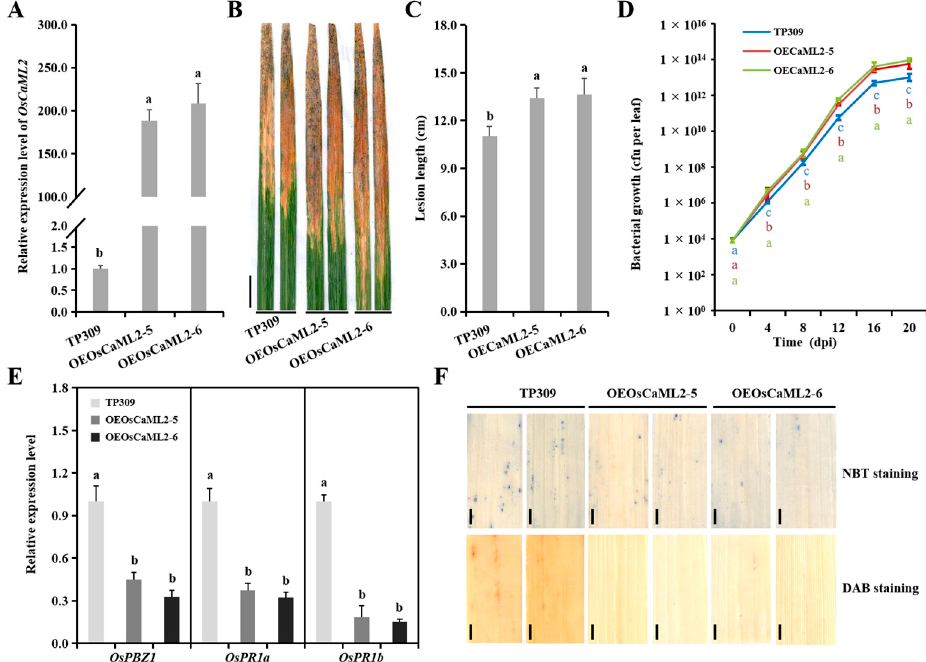
Figure 5. OsCaML2 negatively regulates disease resistance against Xoo in rice. ( A ) Accumulation of OsCaML2 in the OEOsCaML2 transgenic lines. ( B ) Lesions on respective OEOsCaML2 lines (OEOsCaML2-5 and OEOsCaML2-6) and the TP309 at 20 dpi. Scale bar, 2 cm. ( C ) Lesion lengths on OEOsCaML2 plants ( n = 20) at 20 dpi. ( D ) Bacterial growth as indicated by the numbers of colony-forming units (cfu) per leaf for OEOsCaML2 lines and the TP309. ( E ) Expression pattern of OsPBZ1 , OsPR1a and OsPR1b in OEOsCaML2 transgenic lines and the TP309. ( F ) The histochemical detection of ROS levels using NBT and DAB staining in OEOsCaML2 transgenic lines and the TP309 after Xoo infection. Error bars indicate SD ( n = 3). Scale bar, 2 mm. Different letters above the bars indicate significant differences ( p < 0.01) determined by one-way analysis of variance (ANOVA) followed by post hoc Tukey HSD analysis.